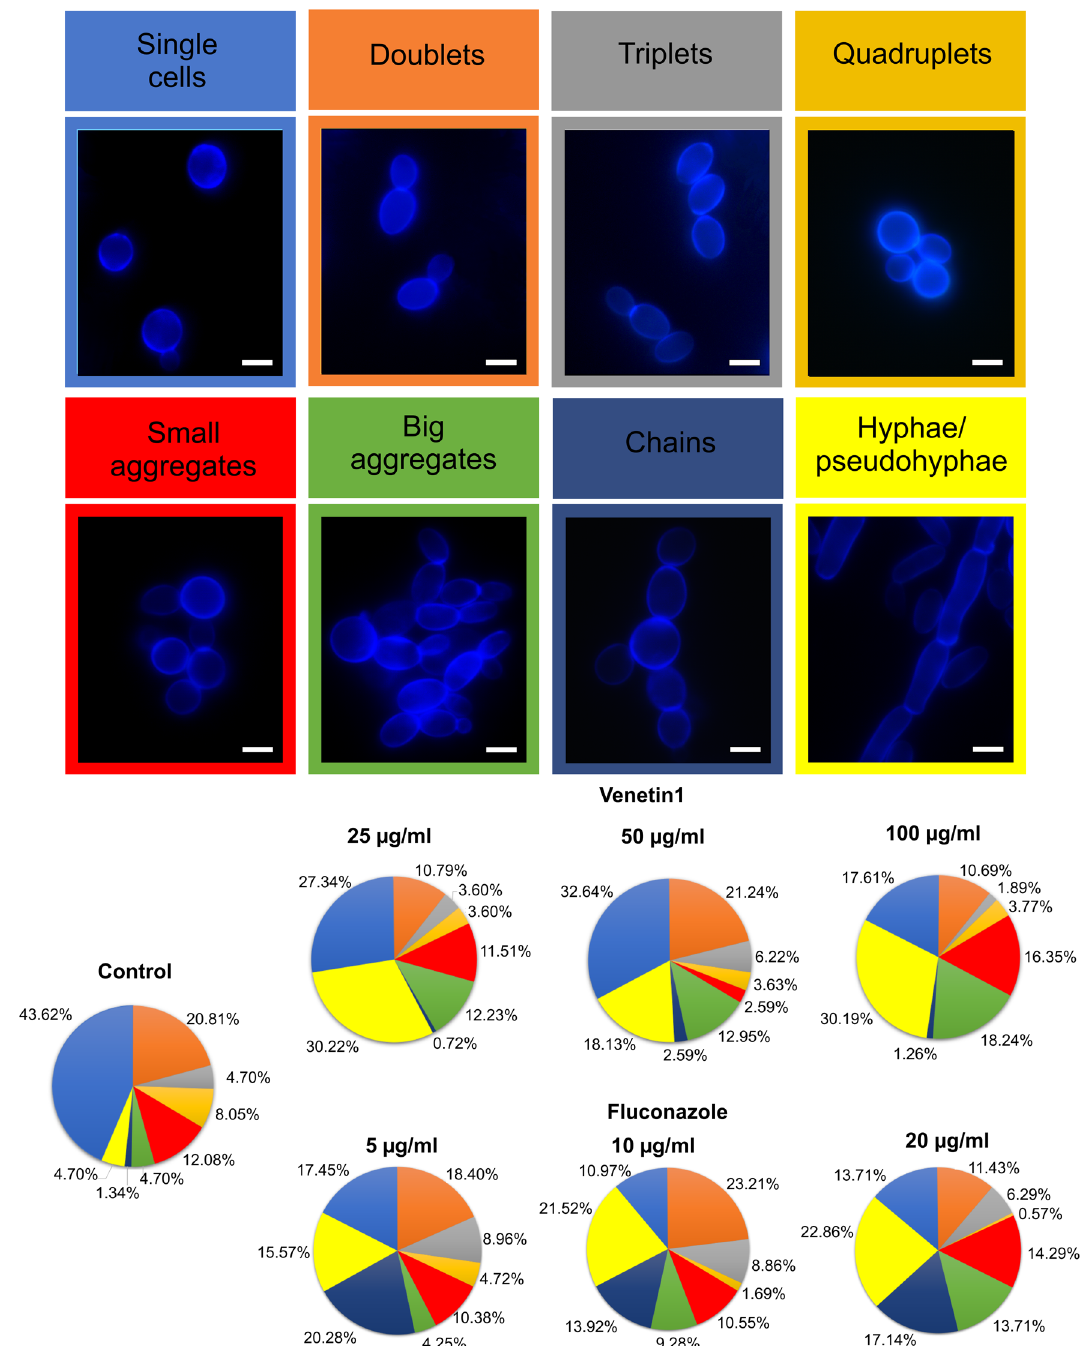
Figure 2. Types of aggregates in the control C. albicans culture and cultures incubated with different concentrations of Venetin-1 and fluconazole. The colors presented on the upper panel correspond to the colors on the pie charts. The scale bar represents 2 control culture, 30.19% in the culture incubated with Venetin-1 (at 100 µg mL −1 ) and 22.86% after the incubation with fluconazole (at 20 µg mL −1 ) (Fig. 1). Visualization of the C. albicans cell wall after staining with Congo red. The Congo red staining of the control showed that the cells were round or oval with slight red fluorescence of the cell wall (Fig. 3 I A). The cells observed after the incubation with Venetin-1 at a concentration of 25 µg mL -1 were larger, with stronger fluorescence (Fig. 3 I B). Picture I C shows changes in the cell shape as well as an increase in their size after the treatment with Venetin-1 at 50 µg mL −1 (Fig. 3 I C). Non-separated cells and red fluorescence were observed on